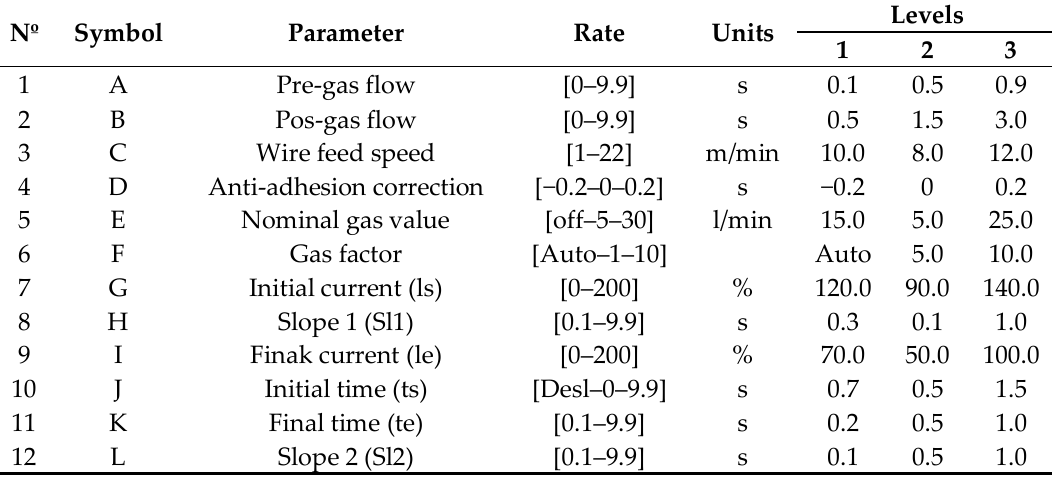
Table 2. Parameters and levels which were used to